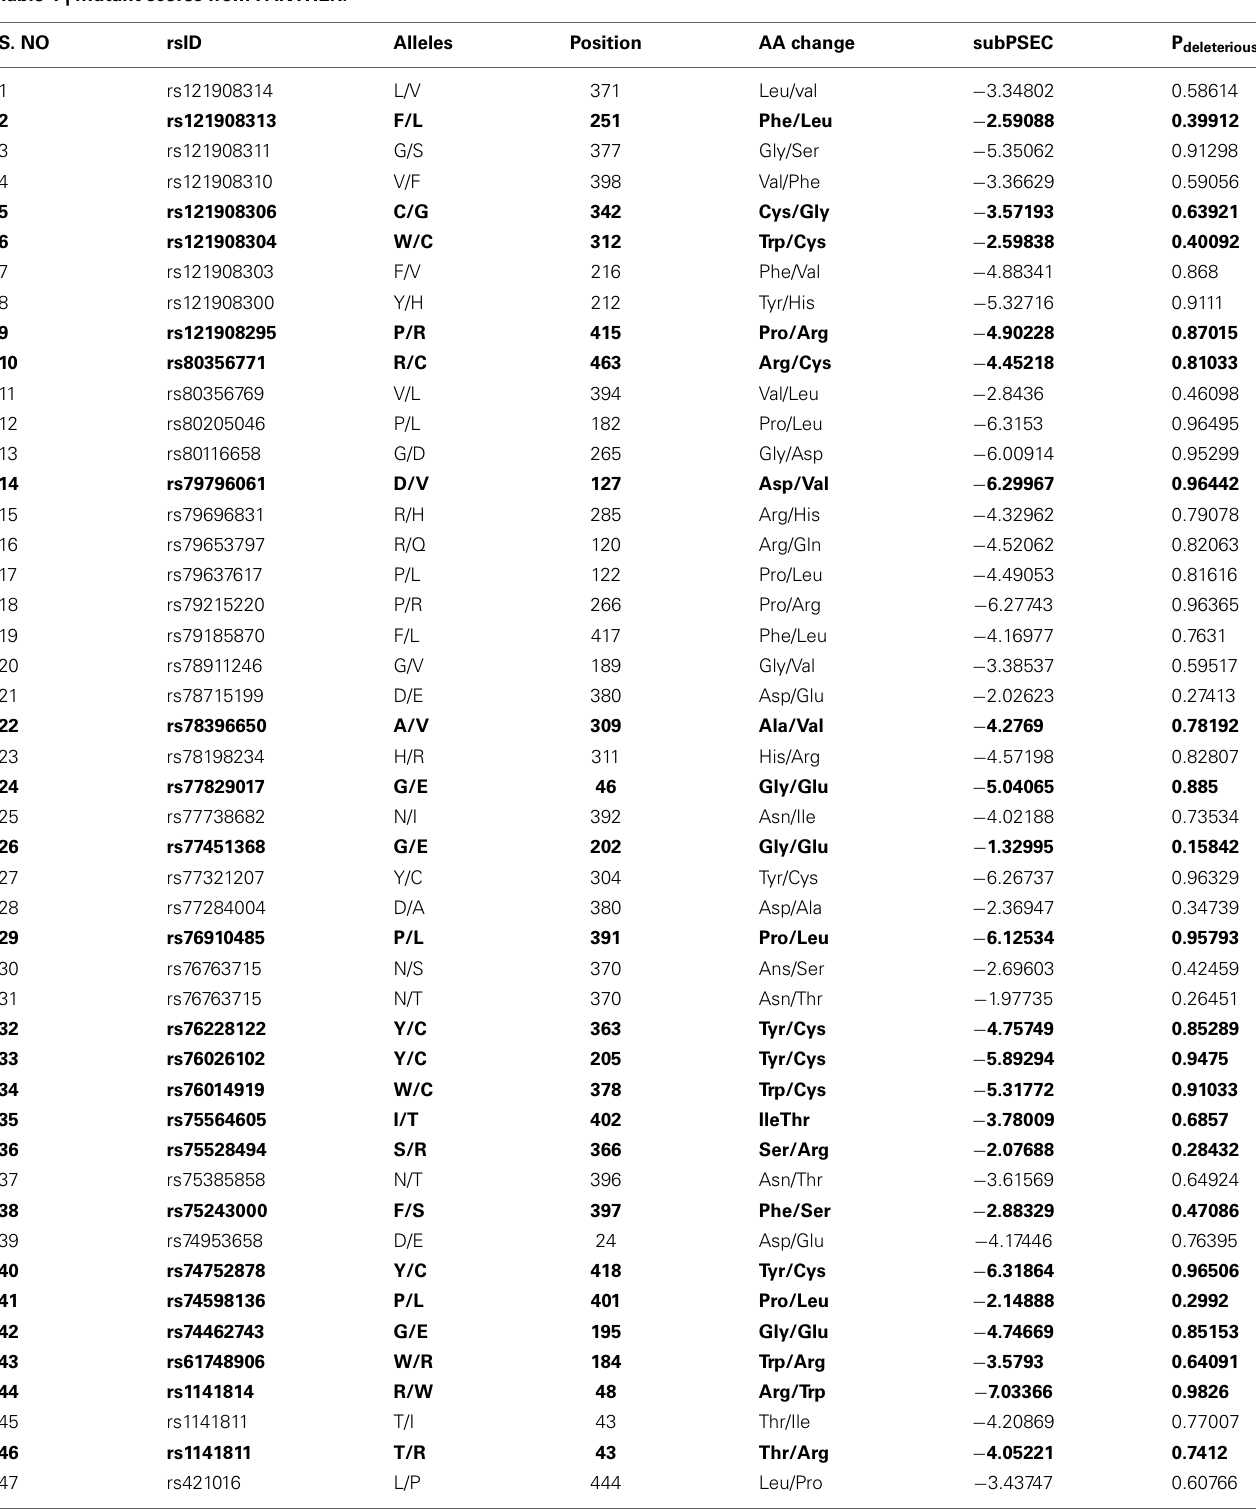
Table 4 | Mutant scores from